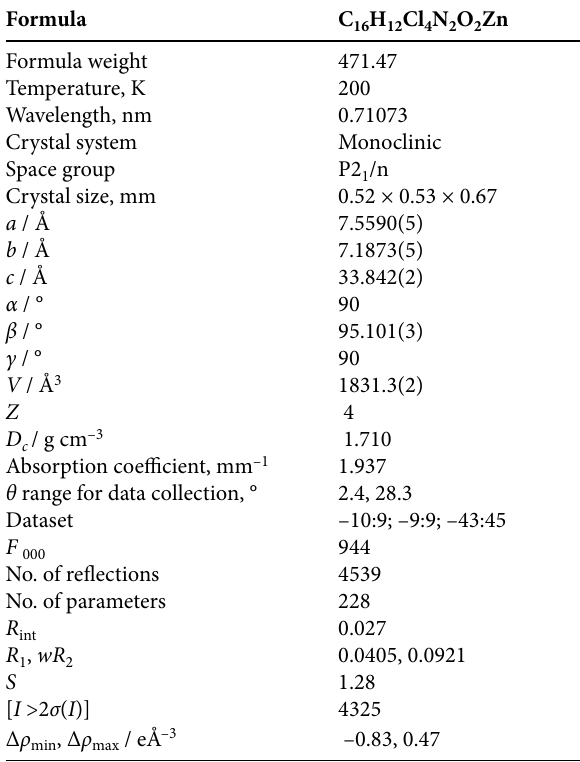
Table 1. Crystal data and structure refinement of the complex